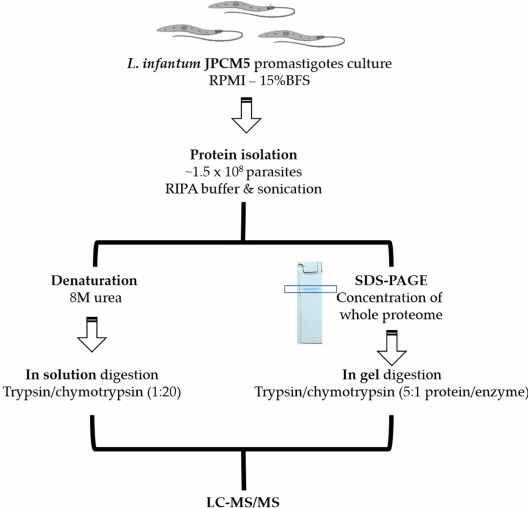
Figure 1. Workflow for protein extraction and proteomic analyses of Leishmania infantum promastigotes. The experimental MS data were searched against the UniProt protein database and a database consisting of all possible polypeptides encoded in the six-frames of the L. infantum genome (based on v2 / 2018; www.leish-esp.cbm.uam.es;